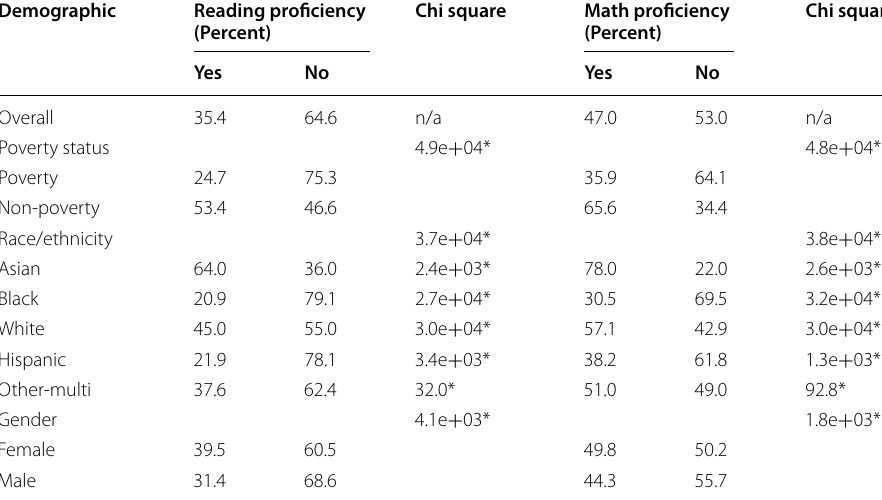
* Statistically significant at p <